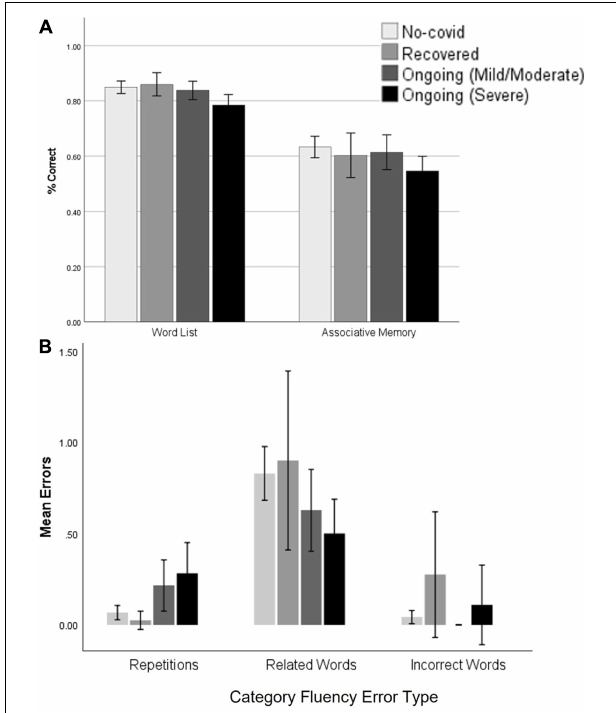
FIGURE 3 | Word List and Associative Memory performance across ongoing symptom groups (A) ; Category Fluency errors across groups on ongoing symptom severity (B) . Error bars: ± 2